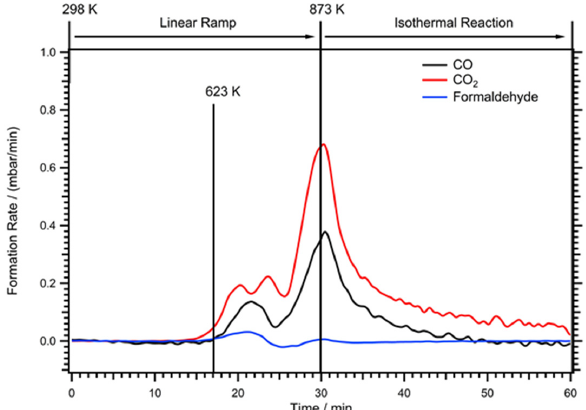
Figure 6. Methanol steam reforming on the Pd ‐ Zr system with nominal starting stoichiometry of Pd:Zr = 2:1. Reaction profile as indicated, reaction conditions: 12 mbar methanol, 24 mbar water, 8 mbar Ar and He added to 1 bar total pressure.